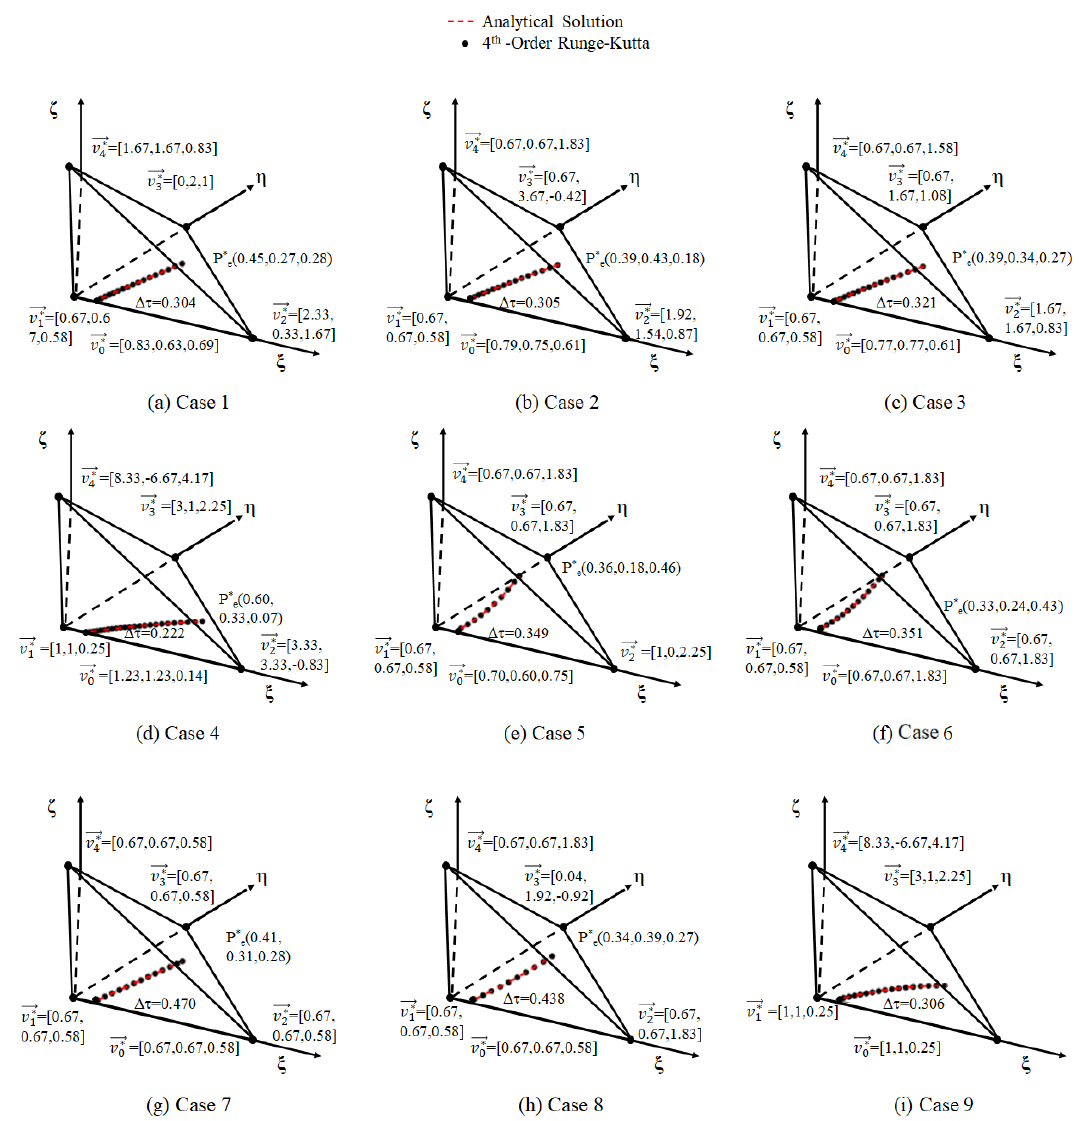
Figure 4. The comparison of this study result (solid lines) and RK4 result (discrete points) for di ff erent cases in Master Element. ( a – i ) represents the result of comparison trajectory between this study and RK4 for Case 1, Case 2, Case 3, Case 4, Case 5, Case 6, Case 7, Case 8, and Case 9, respectively.